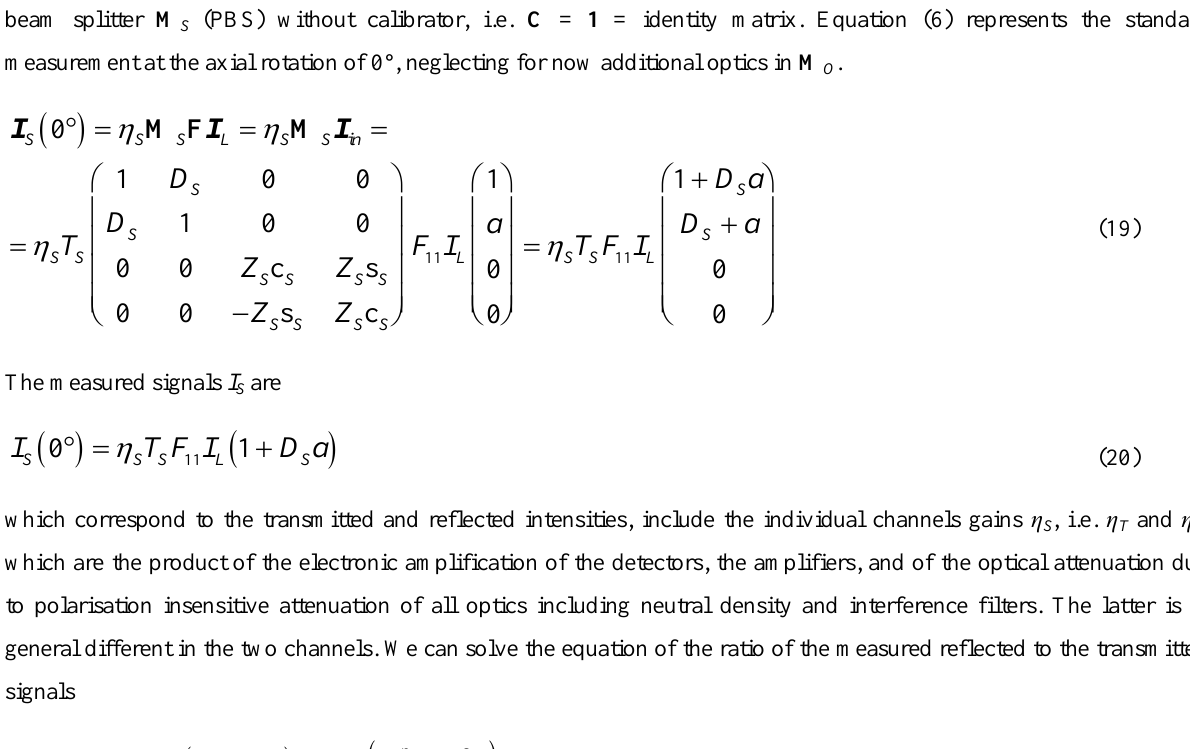
Equation (6) shows the Stokes vectors of the transmitted ( I beam splitter M (PBS) without calibrator, i.e. C = 1 = identity matrix. Equation (6) represents the standard S measurement at the axial rotation of 0°, neglecting for now additional optics in M